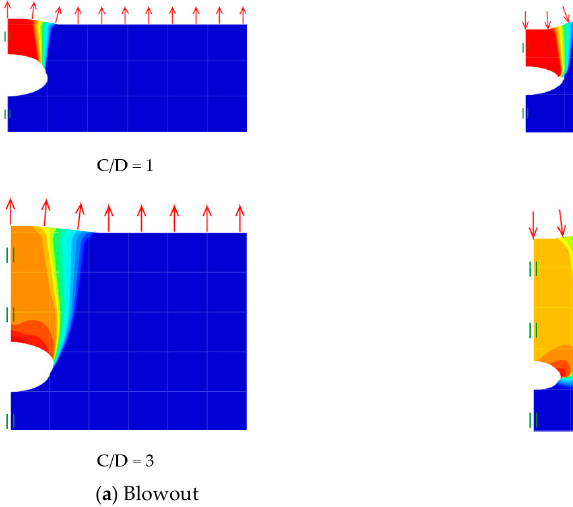
Figure 18. Absolute velocity (|u|) contour plot ( B/D = 1).